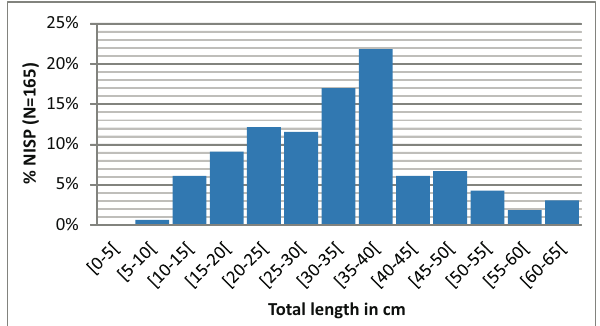
Figure 7: Reconstructed size distribution of salmonids from layer 3 ( N = 165 vertebrae )